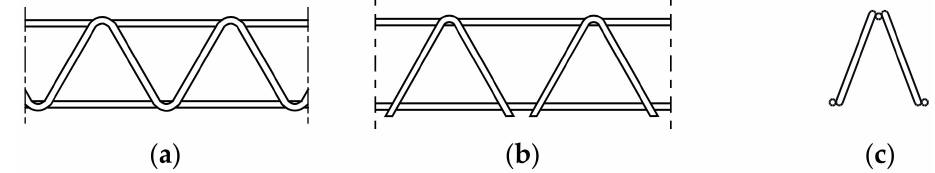
Figure 2. Lattice girder with ( a ) continuous welded or ( b ) discontinuous welded diagonals, and ( c ) section